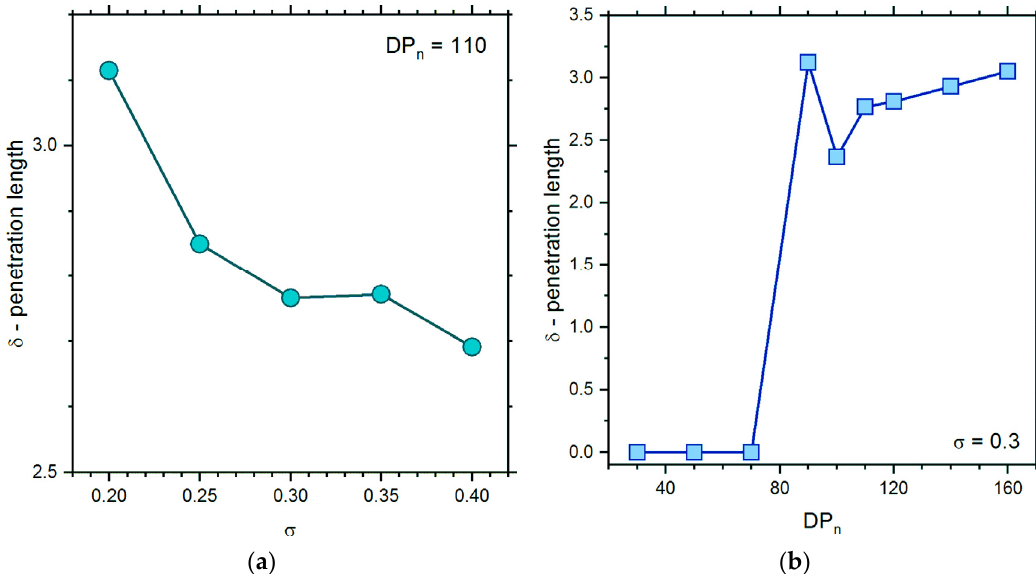
Figure 6. The interpenetration length δ as a function of the number-averaged degree of polymerization DP n ( a ) and of grafting density σ ( b ).